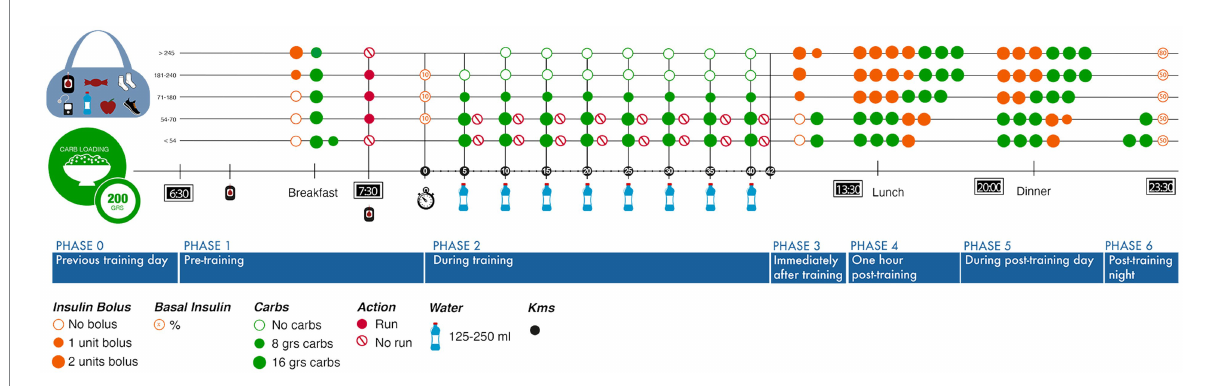
FIGURE 4 Journey map running designed according to training phases and glycemic control